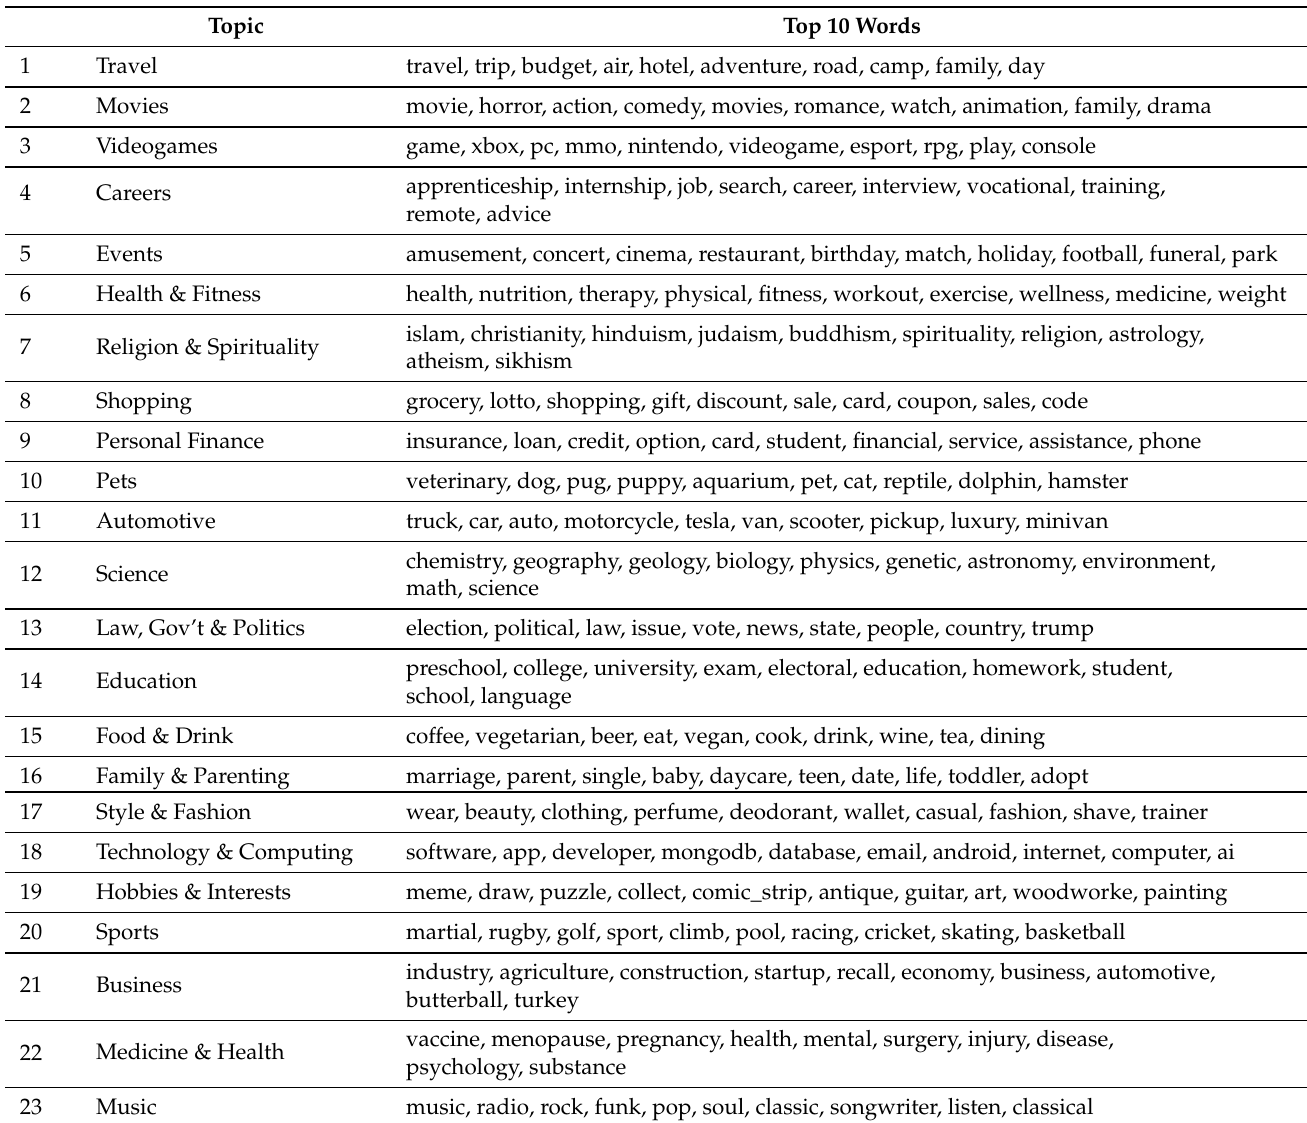
Table 5. Topics obtained by the